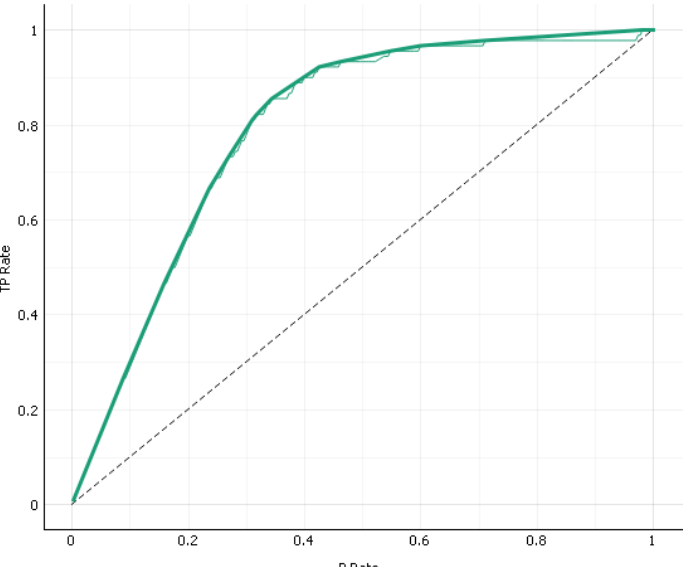
Figure 7. Lift analysis for the training and test comparison. Performance of a classification model at all classification